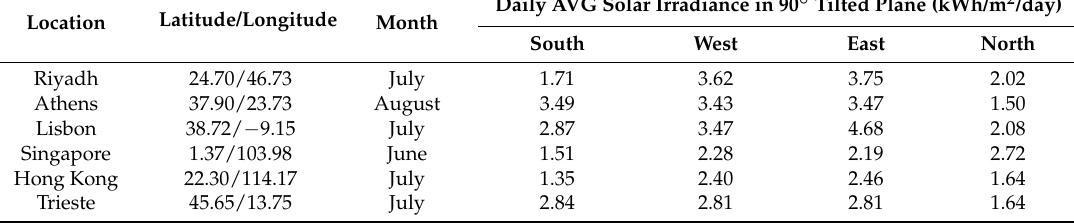
Table 4. Daily average solar irradiance in facades in all orientations and locations for the summer design